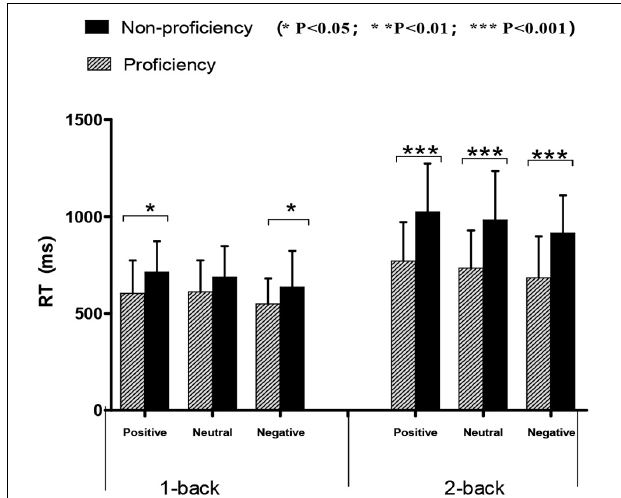
FIGURE 4 | Mean score and standard deviation for RTs on emotional N -back task by different language groups. The RTs of proficient bilinguals was shorter than that of non-proficient bilinguals, and the difference was significant in most conditions beside in negative/1-back (marginal significant, p = 0.056) and in neutral/1-back